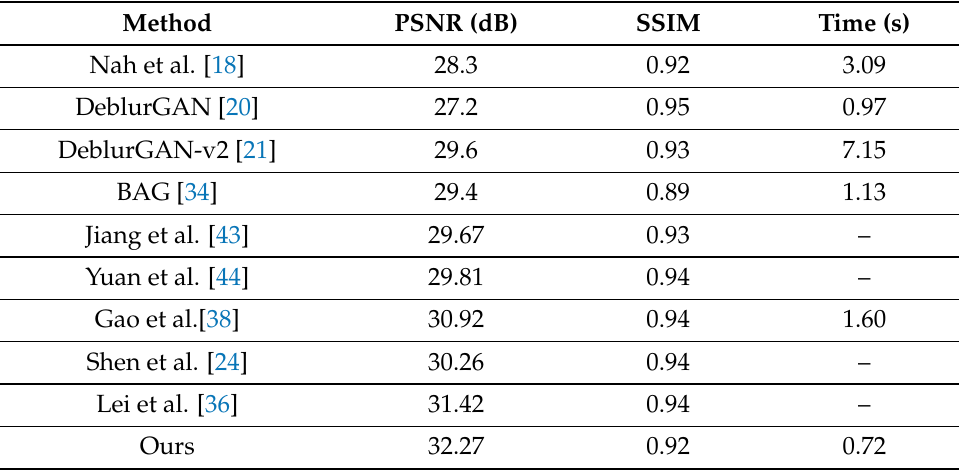
Table 2. Average PSNRs, SSIMs, and running time on the GoPro